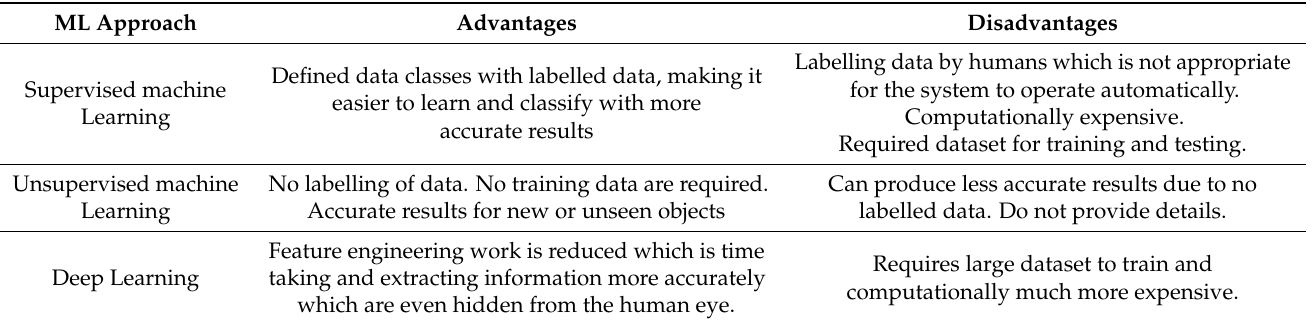
Table 2. Machine learning approaches: a comparison.